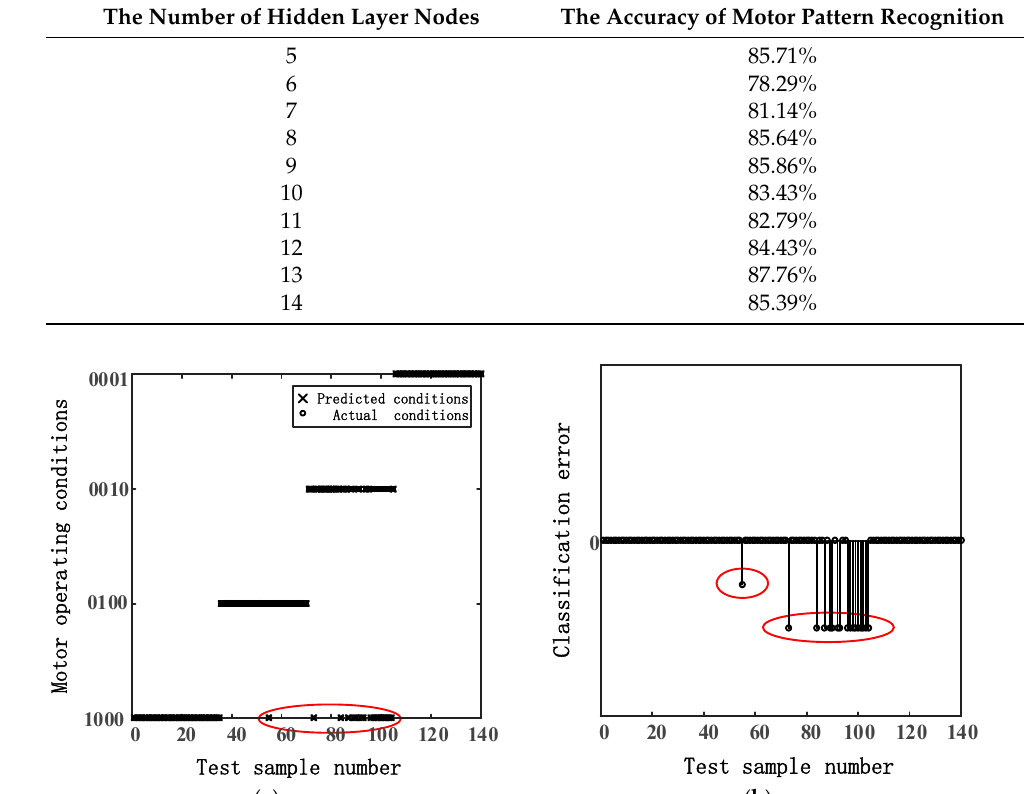
Table 3. Accuracy of motor pattern recognition.